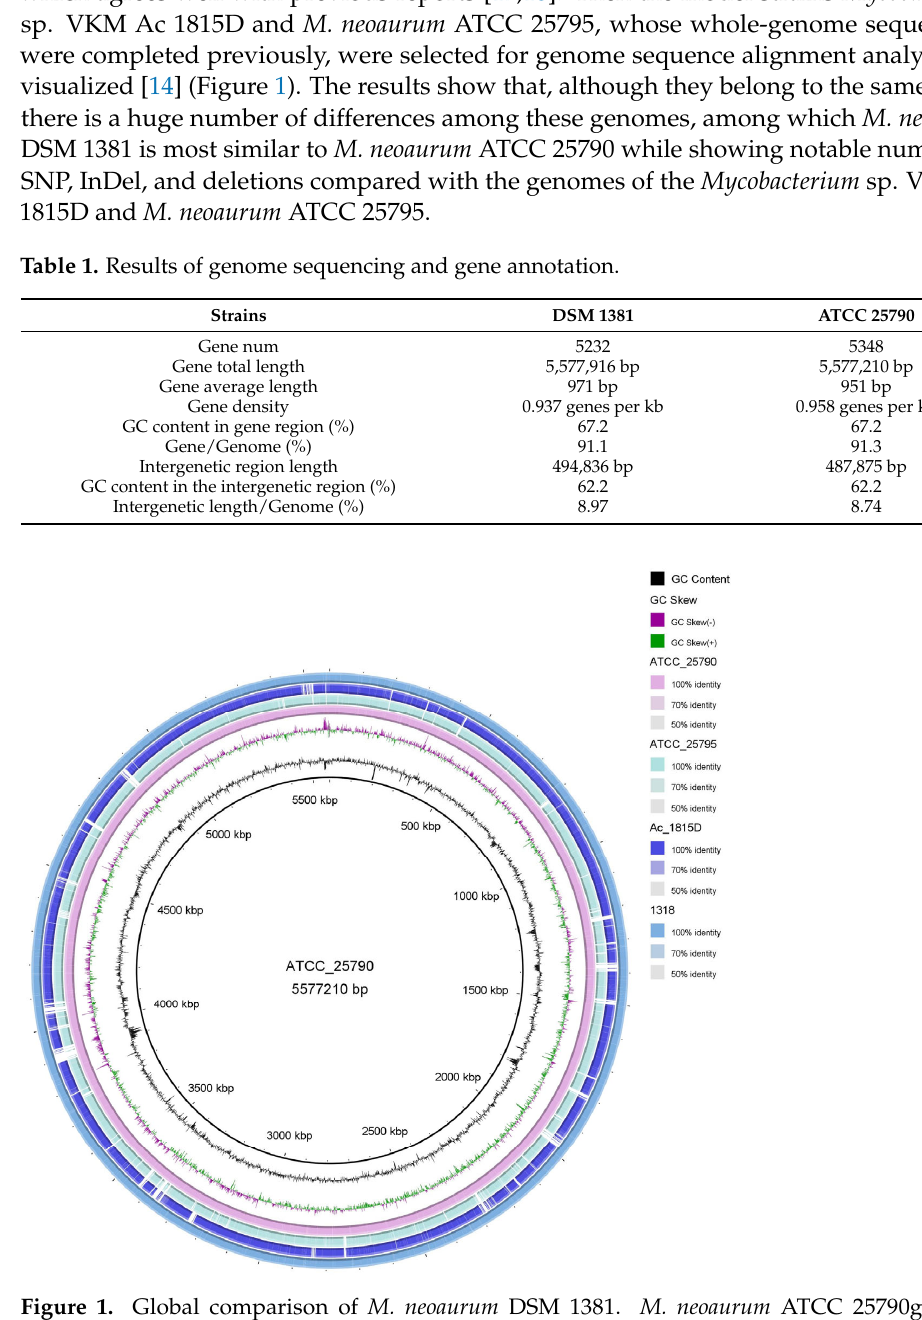
Figure 1. Global comparison of M. neoaurum DSM 1381. M. neoaurum ATCC 25790genomes, M. neoaurum ATCC 25795, and Mycobacterium sp. VKM Ac 1815D sequence.